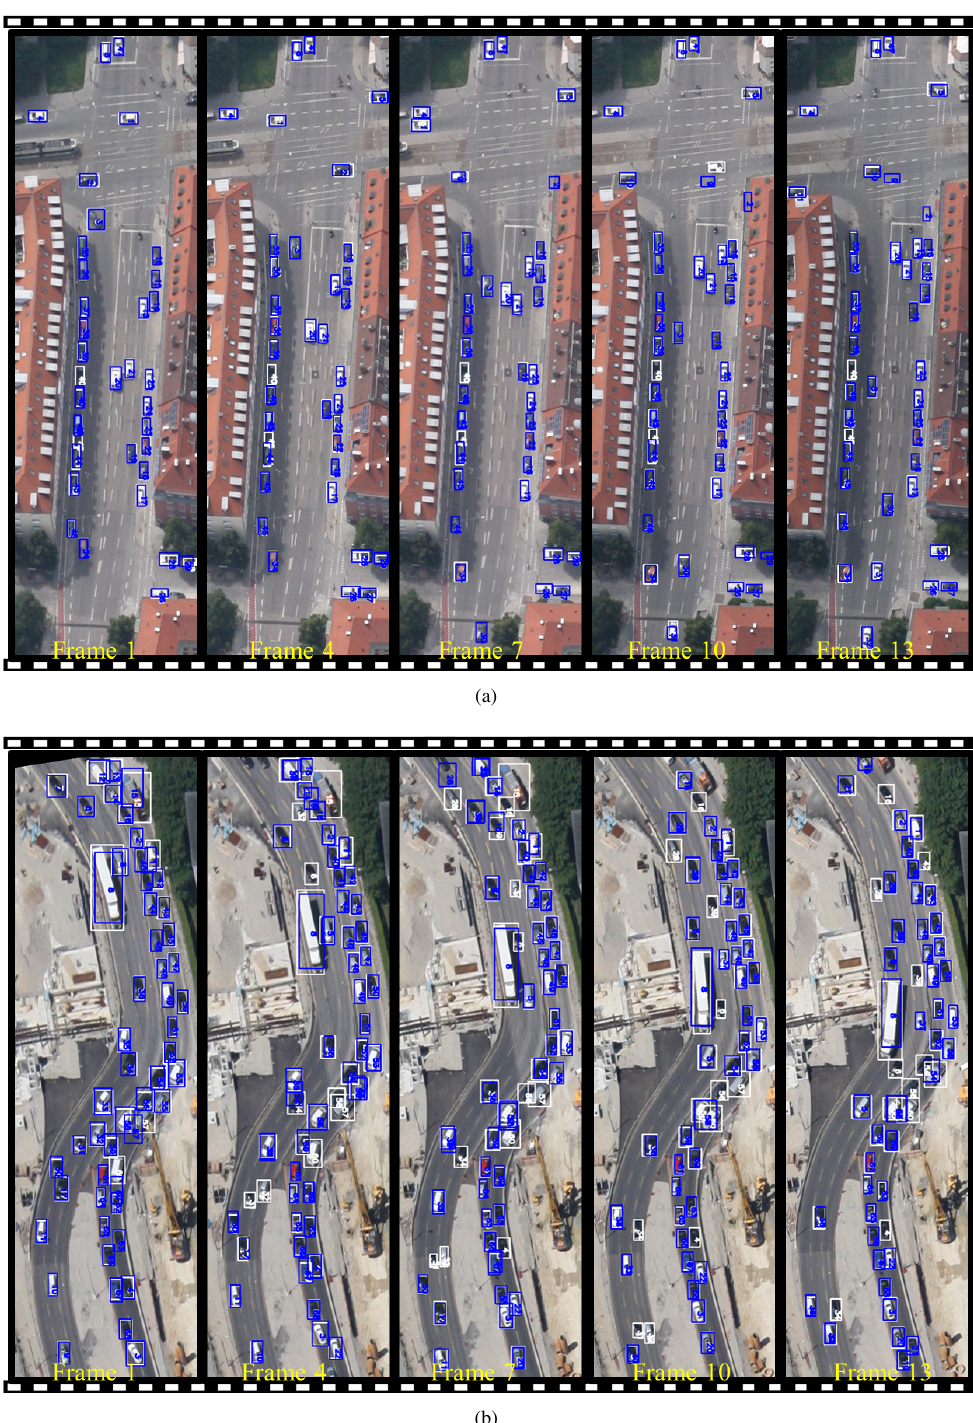
Figure 6. Sample illustrations of the tracking results for the vehicle dataset based on GOT-NF-3Conv/150